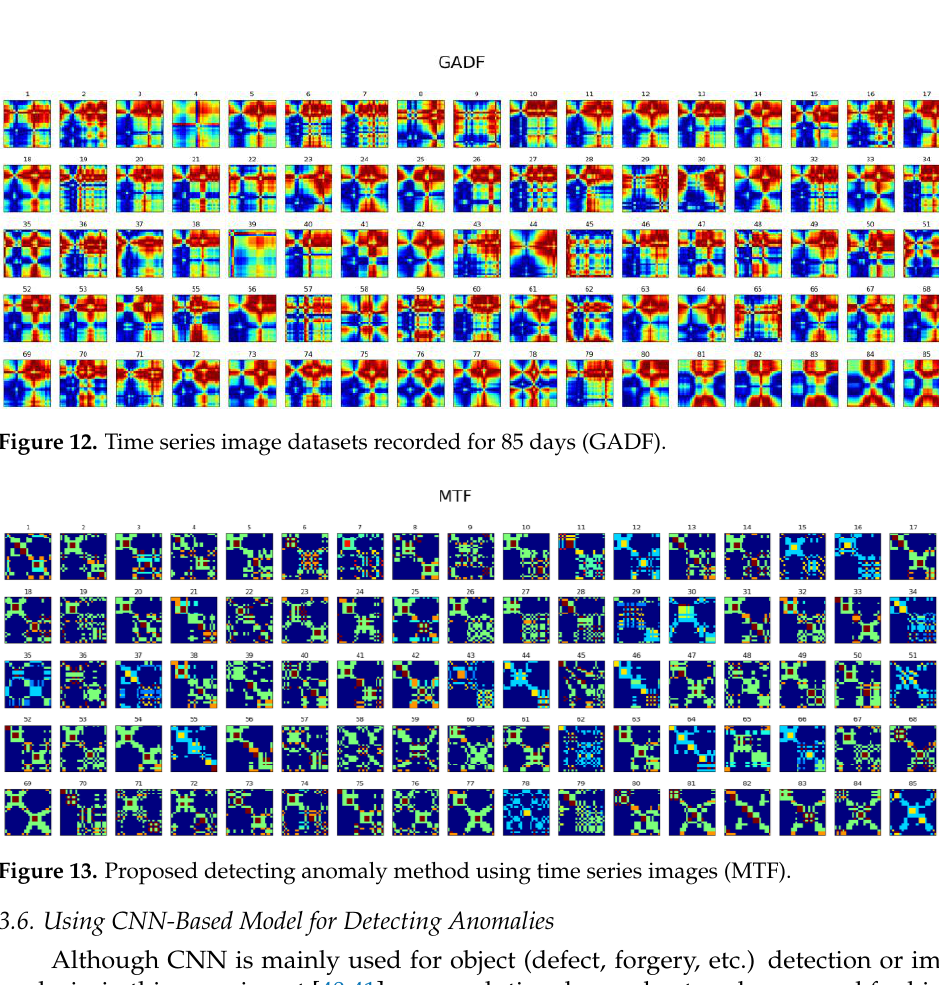
Figure 11. Time series image datasets recorded for 85 days (GASF).